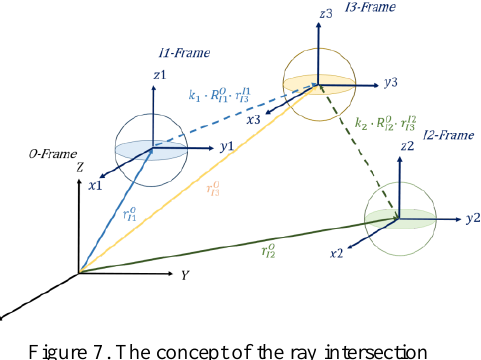
Figure 7. The concept of the ray